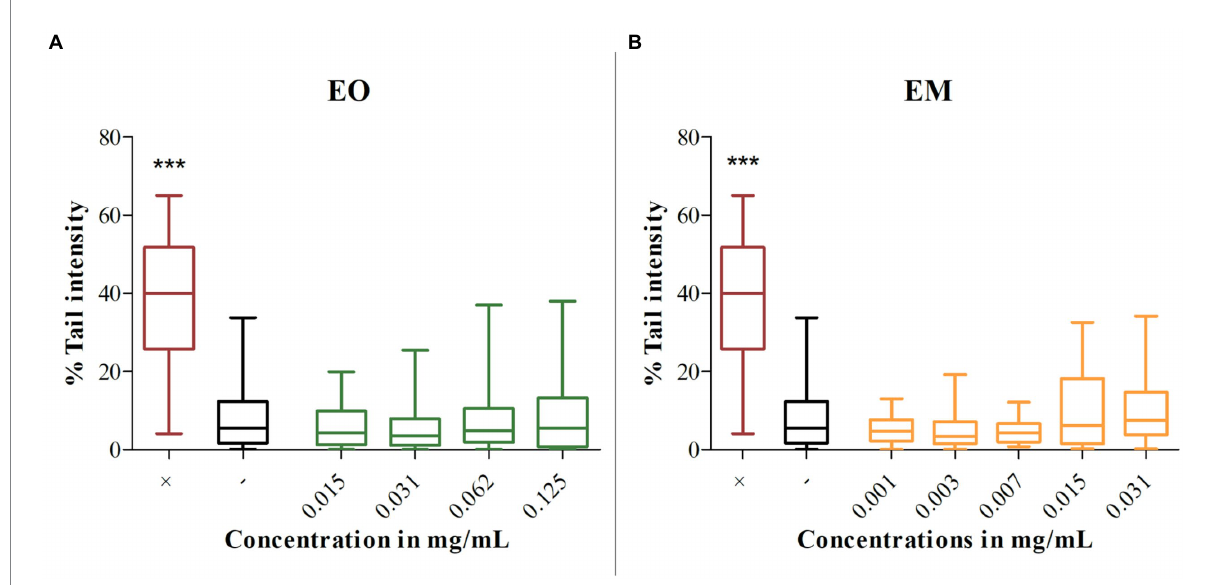
FIGURE 8 Genotoxicity of cinnamon essential oil (A) and cinnamon emulsion (B) . Horizontals lines through boxes are medians of the scored nuclei per tested substances. Statistical significance was tested using the Mann–Whitney U -test (*** p < 0.001) concerning control (–). 0.1% H 2 O 2 was used as a positive control